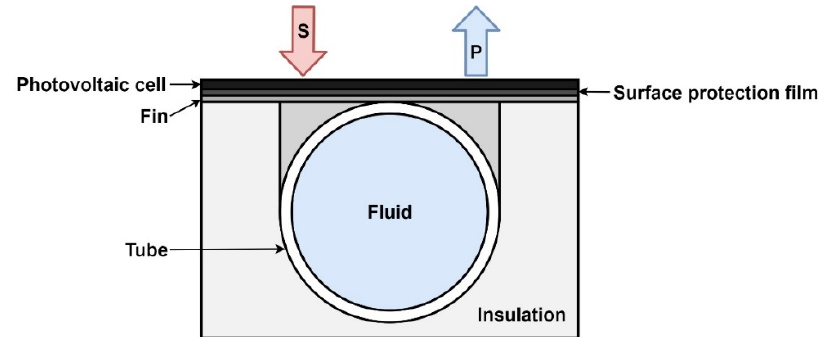
Figure 4. The CPV/T receiver.